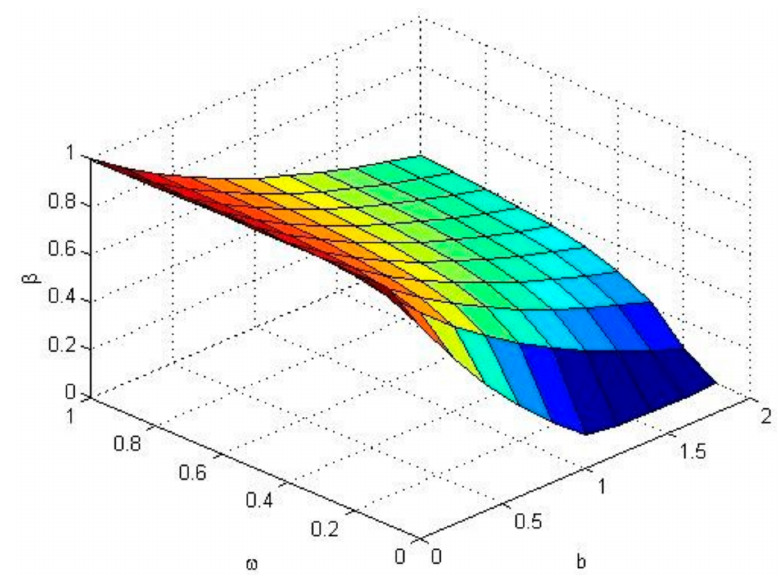
Figure 7. Farmers’ heterogeneity and